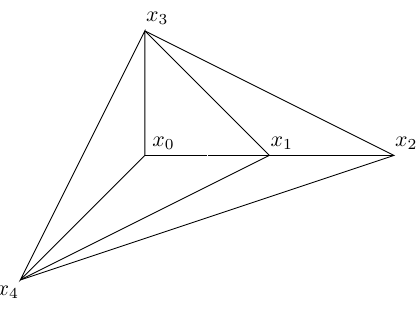
Figure 6 . Fan diagram of resolved C 3 = Z